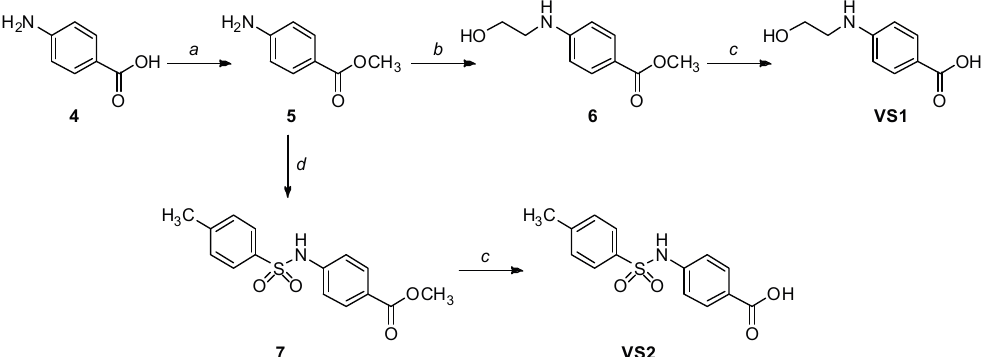
Scheme 1. Synthesis of compounds VS1 and VS2